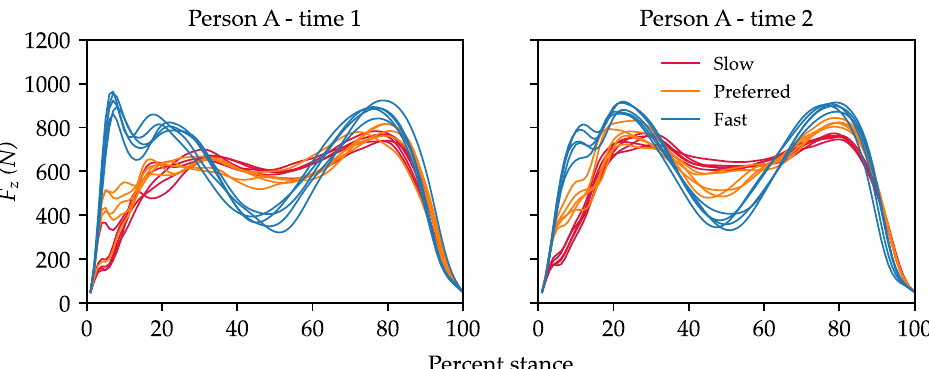
Figure 2. An example of the vertical ground reaction force ( F z ) with changes in walking speed (colors) and footwear ( left vs. right ) between measurement instances. Left —women’s ankle boots (flat sole); right —ballet